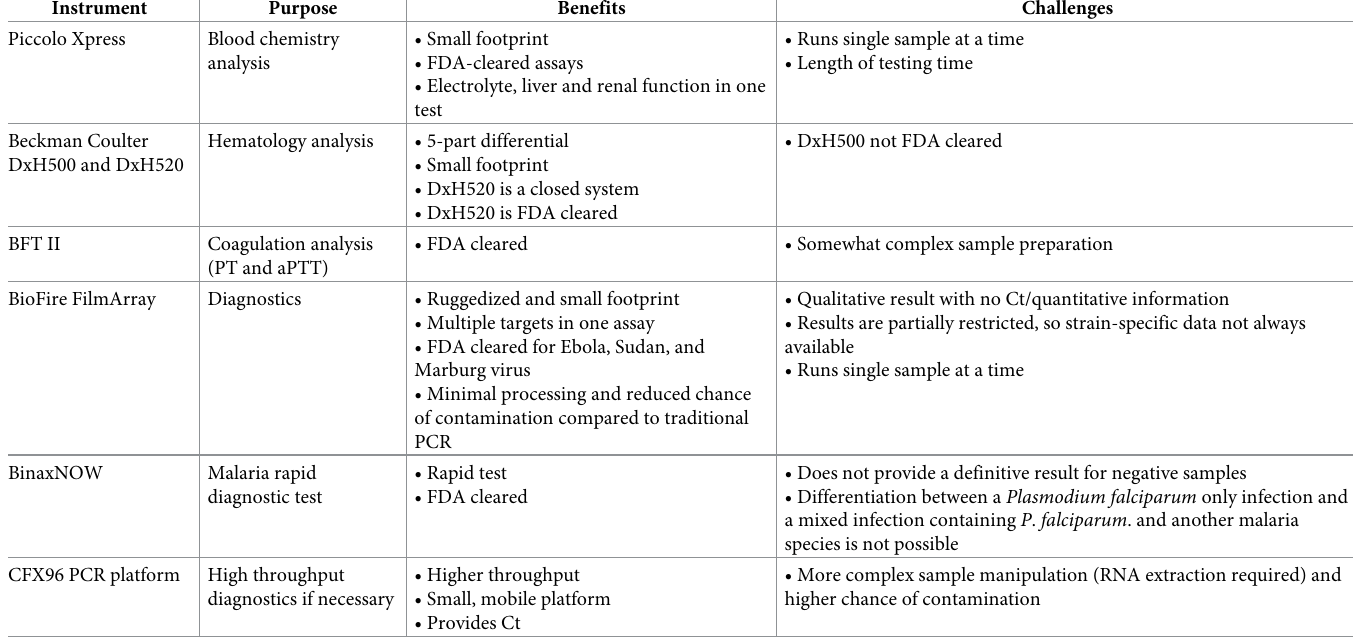
Table 2. Instrument